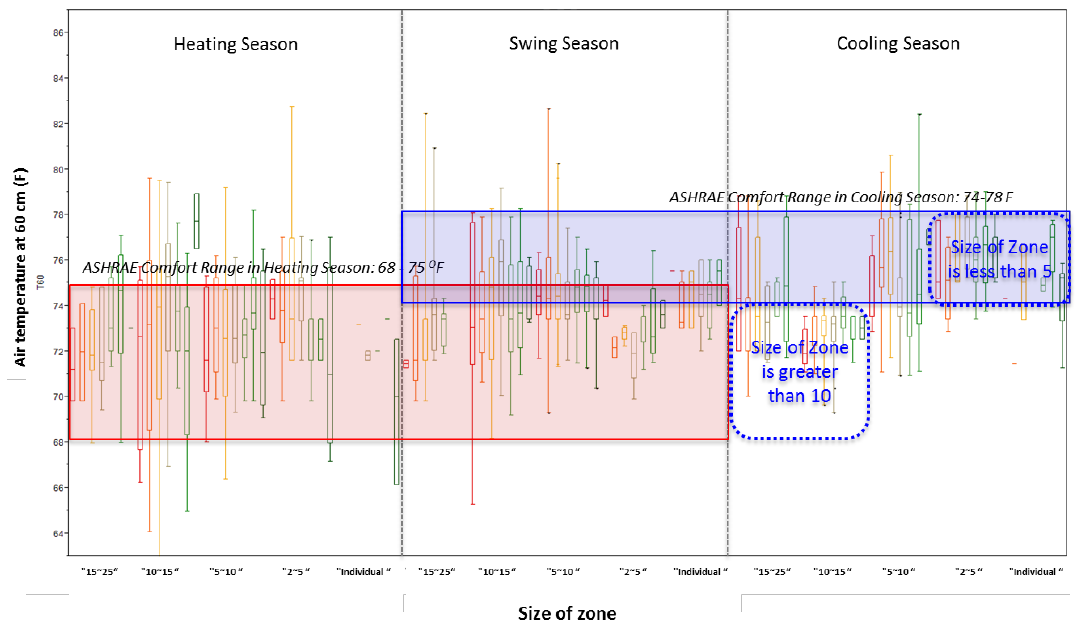
Figure 7. Air temperature of 60 cm from the floor by size of zone, and temperature satisfaction colored by seven scales. Table 11. Distribution in level of control for questionnaire respondents in 64 buildings (divided between open and closed office locations).